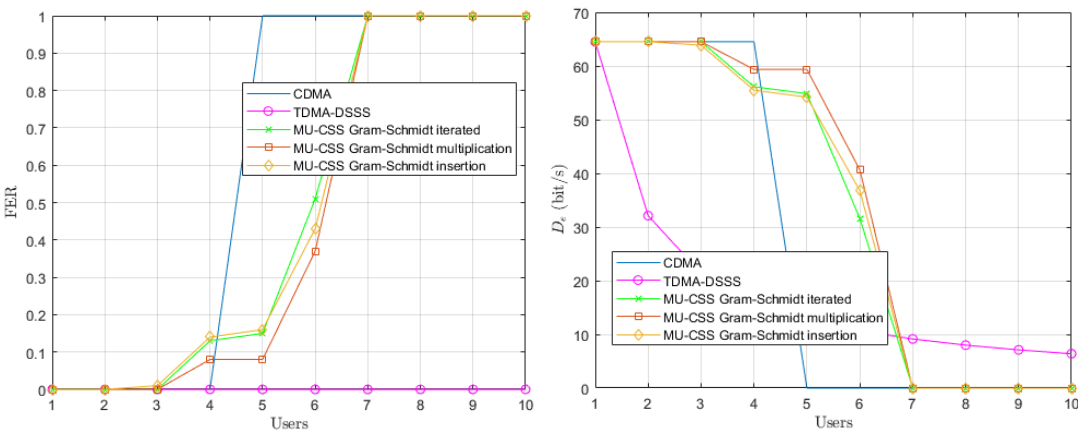
Figure 11. Average FER performance ( left ) and effective data rate per user ( right ) versus number of users for the Ty-Colo lake with the replayed channel with static